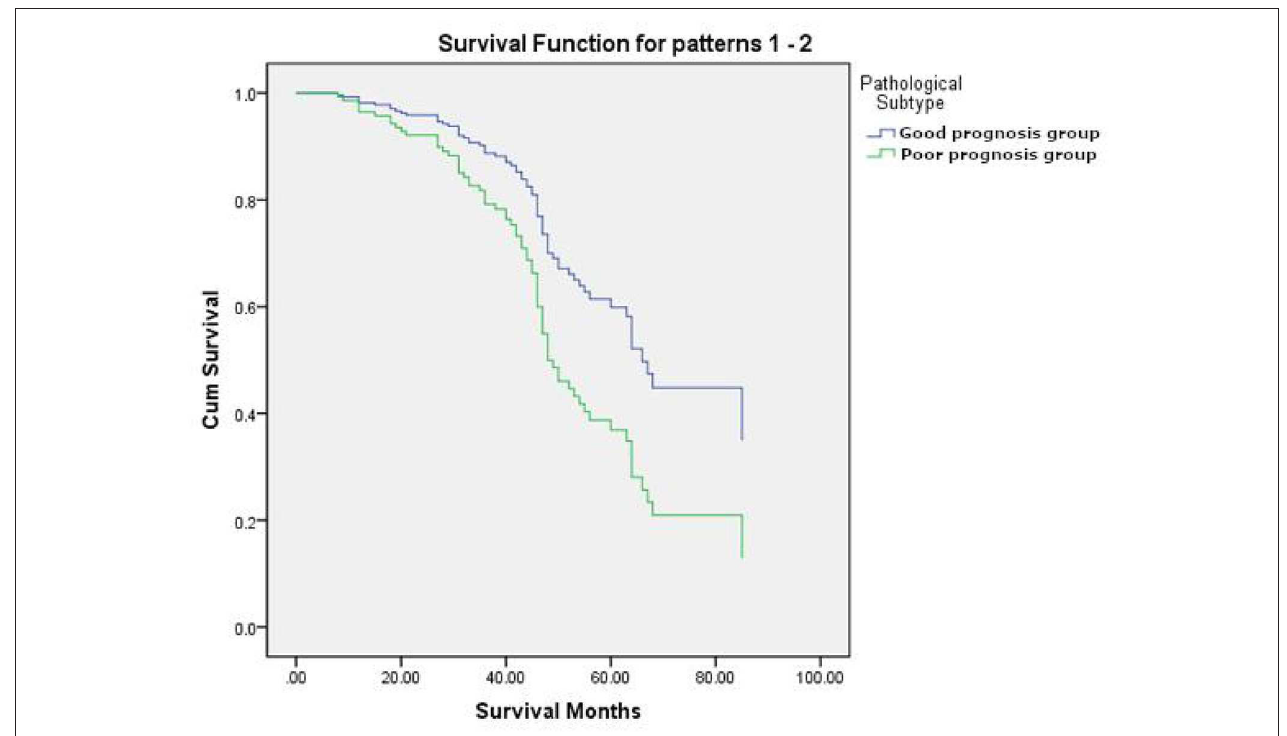
FIGURE 3 | The survival curves of pathological subtypes in good prognosis group and poor prognosis